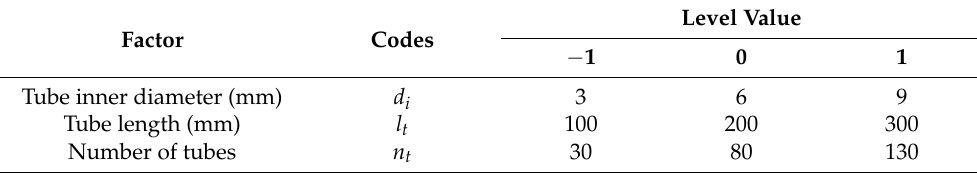
Table 3. Values of the design factors of the HHX.